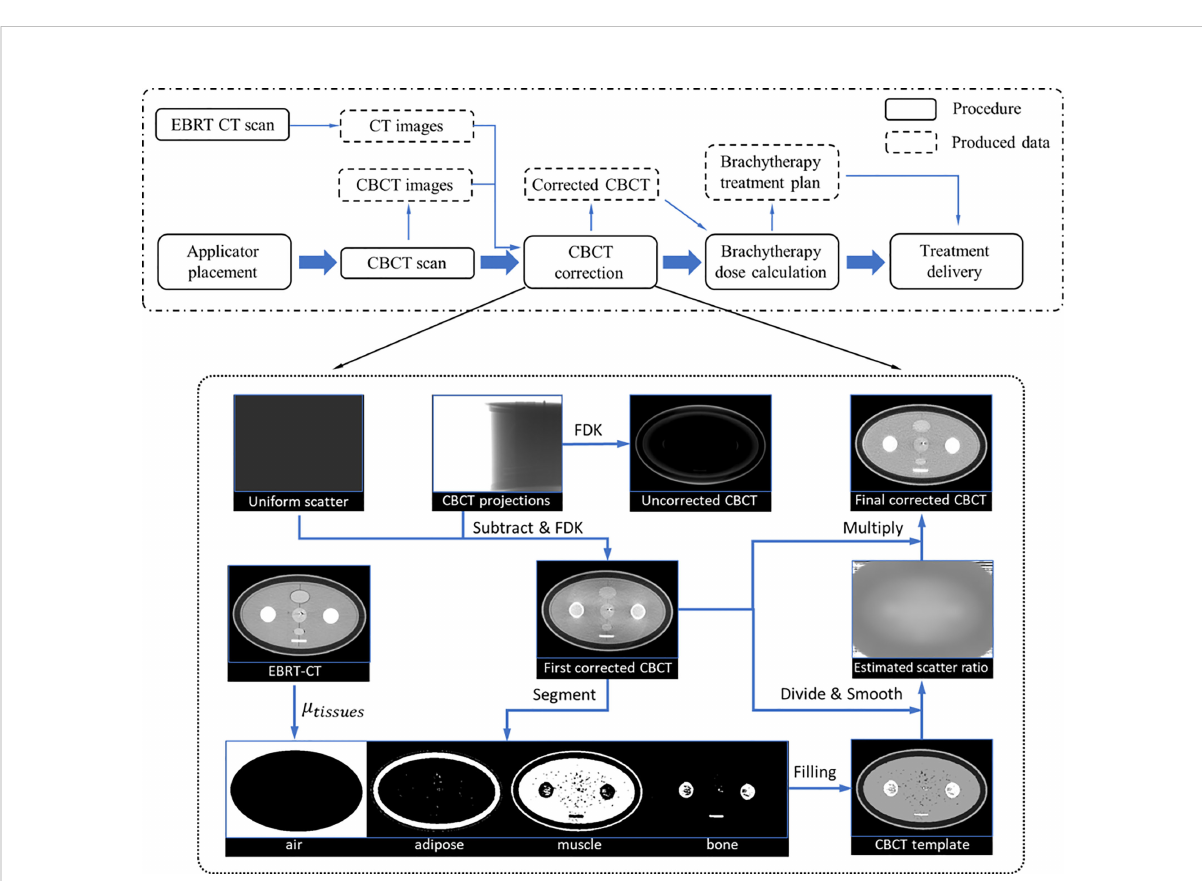
FIGURE 1 Dot-dash boxes: the fl owchart of CBCT-based cervical brachytherapy. Dotted box: detailed work fl ow of the scatter